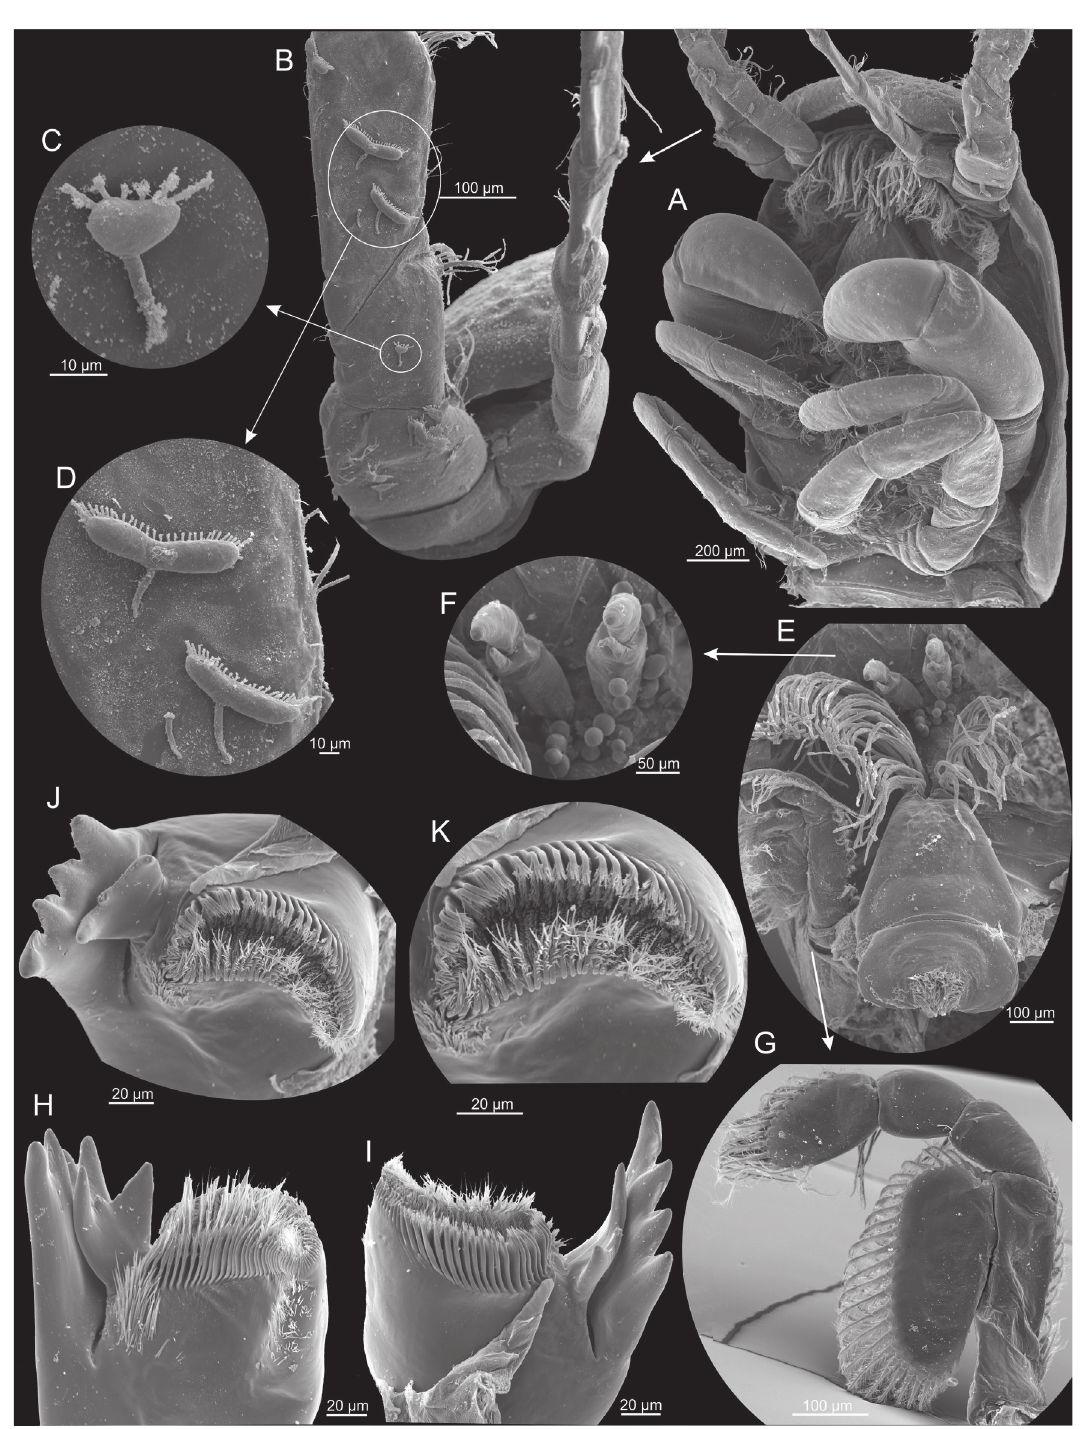
Fig. 5. Xibalbanus cozumelensis sp. nov., paratype (ZMUC-CRU-4792). Cephalon and cephalic structures. Scanning electron microscopy. A . Cephalon with cephalic shield and appendages. B . Antenna 1, right side, proximal parts of dorsal and ventral branches. C–D . Unidentified suctorians attached at the proximo-ventral parts of antenna 1. E . Labrum, frontal filaments, and parts of antennae 1 and 2, right side. F . Frontal filaments. G . Antenna 2, left side from anterior. H . Mandible, left side from anterior. I . Mandible, left side from posterior. J . Mandible, left side, apical view on gnathal edge. K . Mandible, left side, apical view on